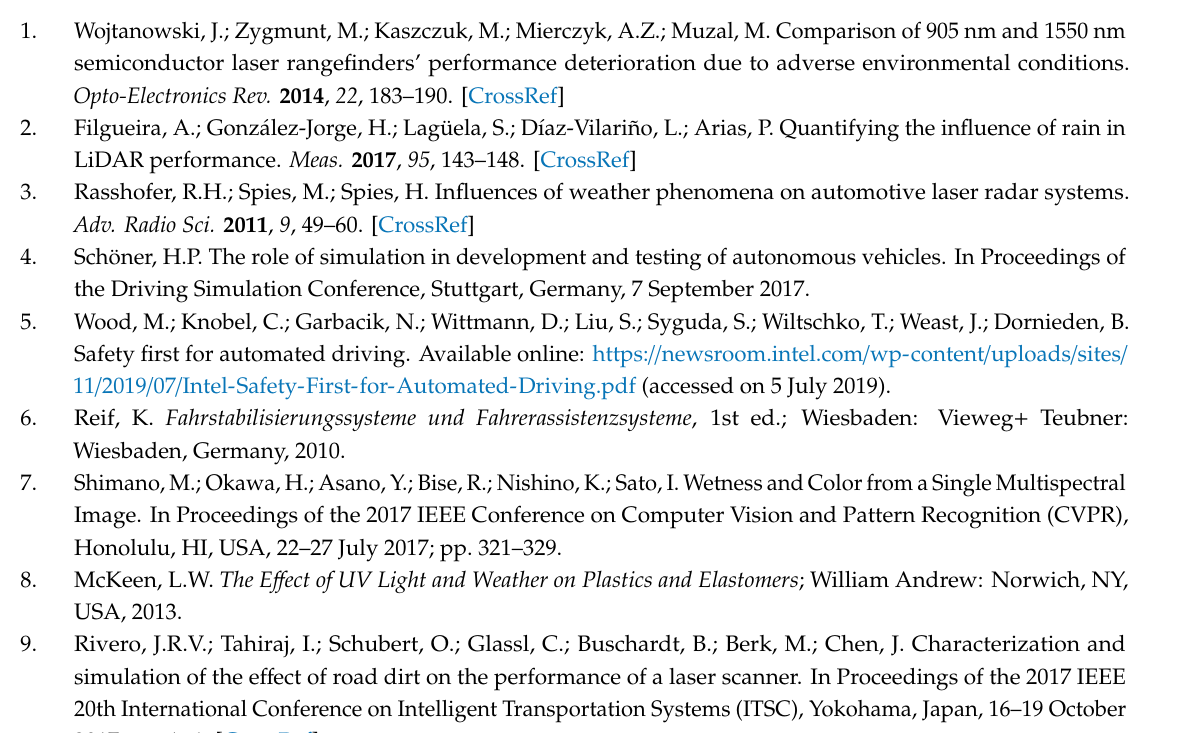
Figure A3. Histogram of the global radiation for all samples with background radiation. The average value varies depending on the class: 343 W / m 2 (Clear), 104 W / m 2 (Rain), 86 W / m 2 (Fog), 13 W / m 2 (Snow).